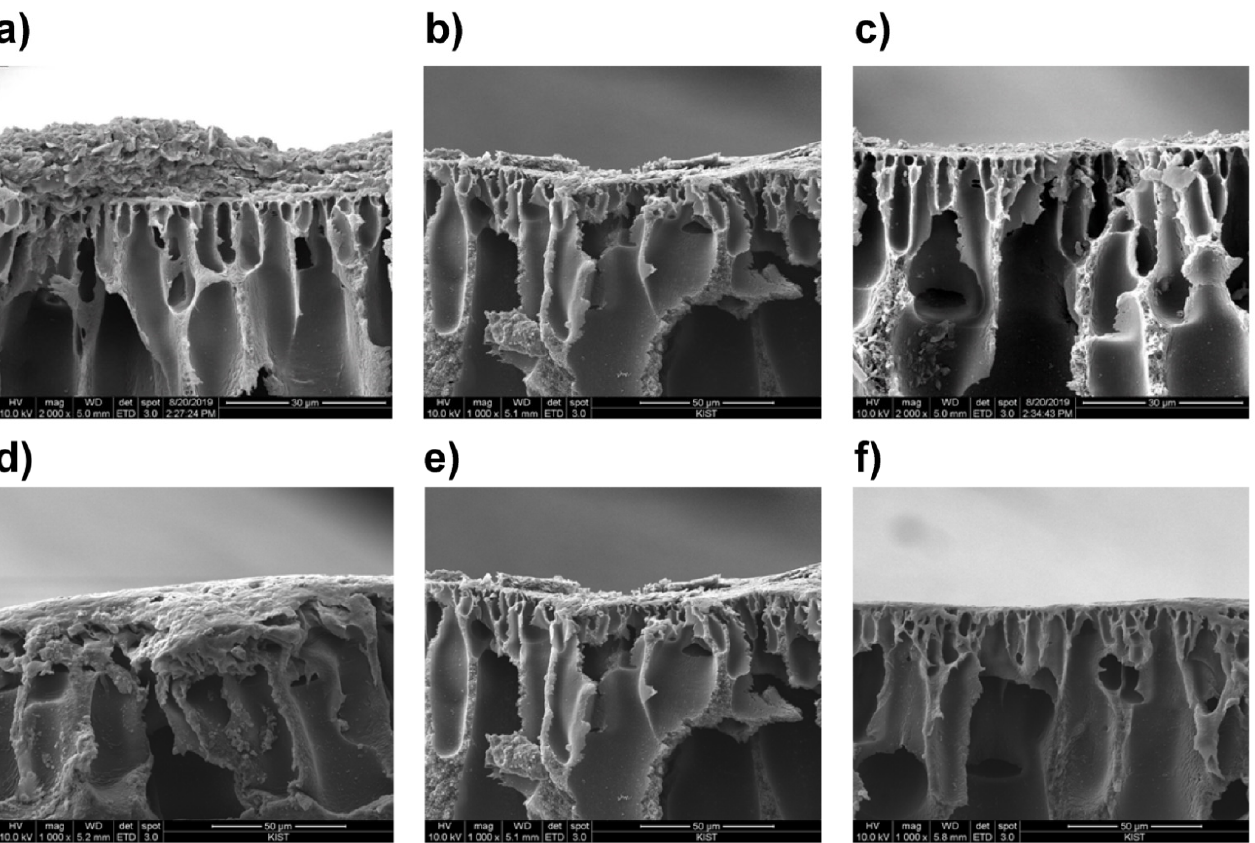
Figure 5. Scanning electron microscopy (SEM) images of the ( a ) membrane fouled by HA, ( b ) HA-fouled membrane after hydraulic backwashing, ( c ) HA-fouled membrane after NaClO backwashing, ( d ) membrane fouled membrane by SA, ( e ) SA- fouled membrane after hydraulic backwashing, and ( f ) SA-fouled membrane after NaClO backwashing.